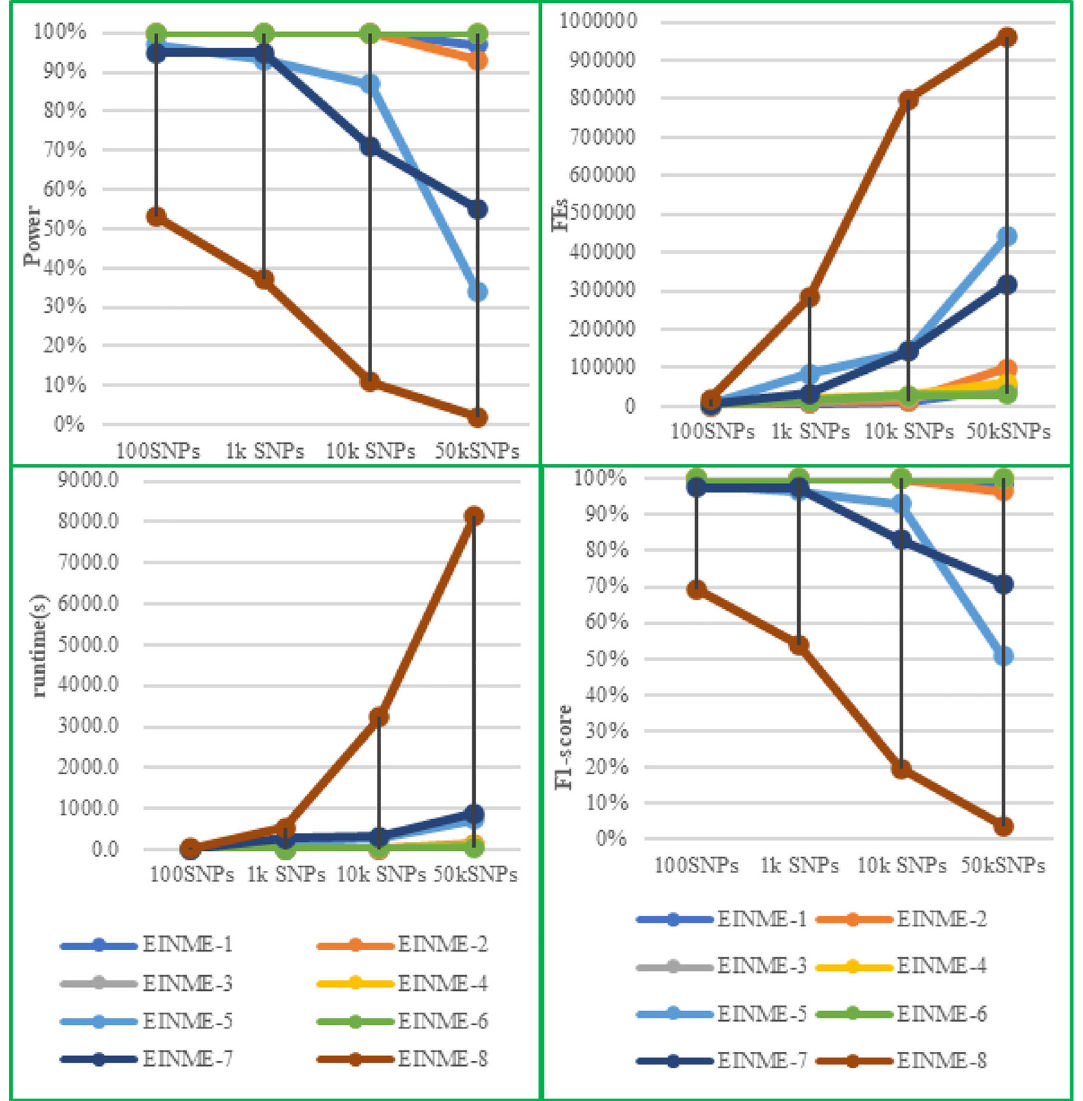
Fig. 9 Change curves of the power, FEs, runtime and F1-score of MTHSA-DHEI with an increasing number of SNPs for